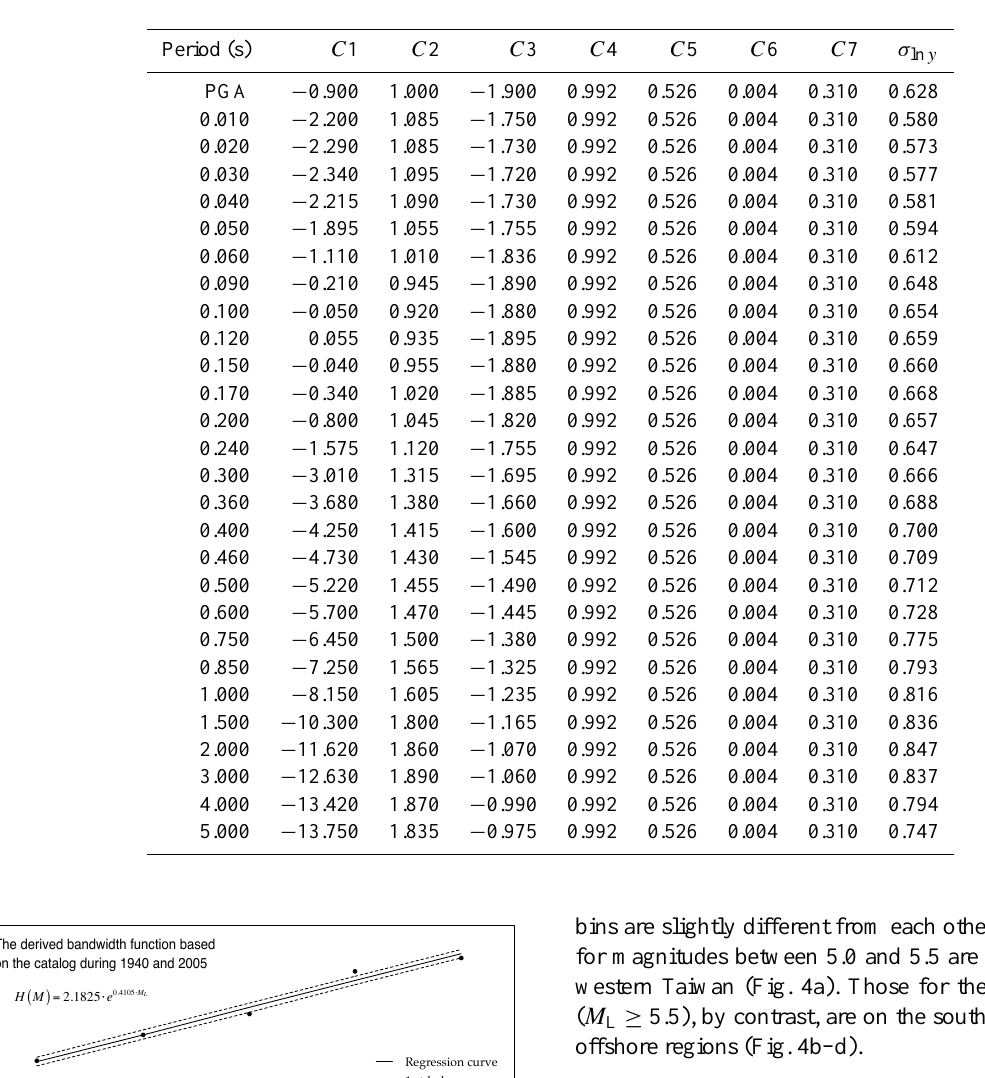
Table 3. Corresponding parameters and standard deviations ( σ ln y ) of the GMPEs for PGA and SA of various response periods for subduction events (Eq. 13) by Lin and Lee (2008).